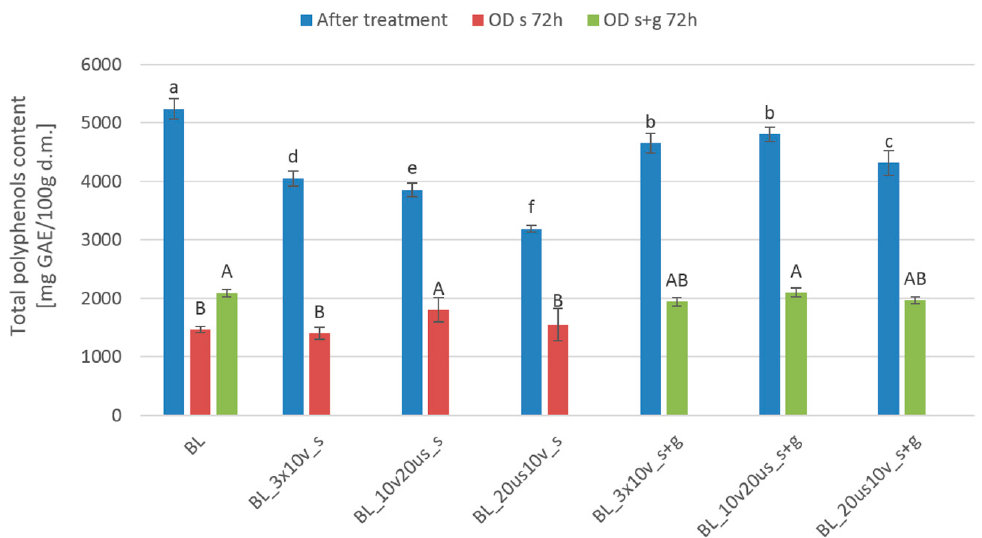
Figure 3. Total phenolic content in di ff erent treated cranberries: Blanched (BL), reduced pressure (BL_3 × 10 v), reduced pressure with sonication treatment (BL_10 v 20 us), sonication treatment with reduced pressure (BL_20 us 10 v), and after osmotic dehydration (OD) in 61.5% sucrose solution (s) and in 30% sucrose solution with 0.1% addition of steviol glycosides (s + g). Different lowercase letters means significant difference by the Duncan test ( p < 0.05) for samples after treatment, and different capital letter means significant difference by the Duncan test ( p < 0.05) for samples after 72 h osmotic dehydration. Flavonoids content of investigated cranberries ranged from 30.0 to 45.8 mg / g d.m. and from 10.5 to 16.7 mg / g d.m. before and after 72 h of OD, respectively (Figure 4). The highest flavonoids content